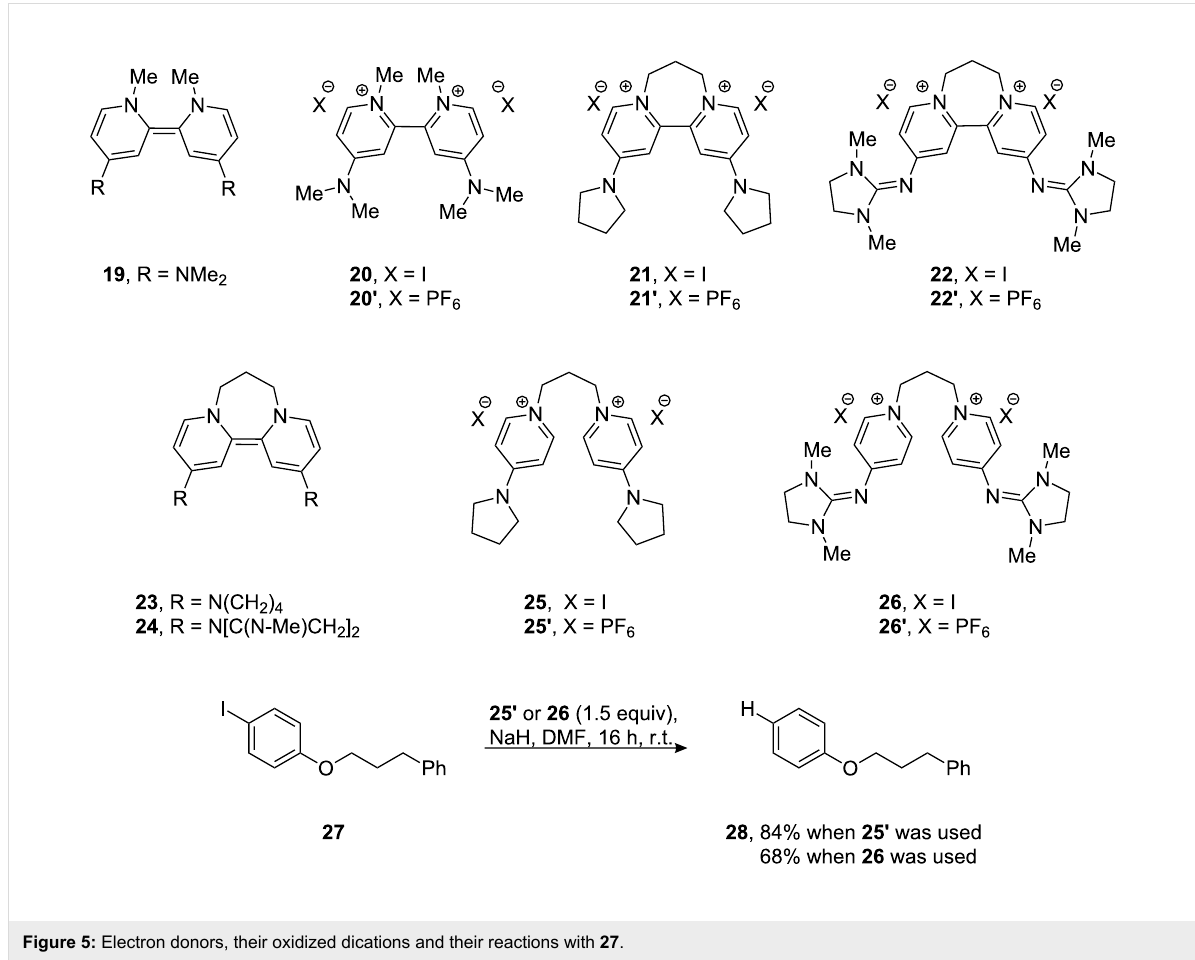
Figure 5: Electron donors, their oxidized dications and their reactions with 27 .